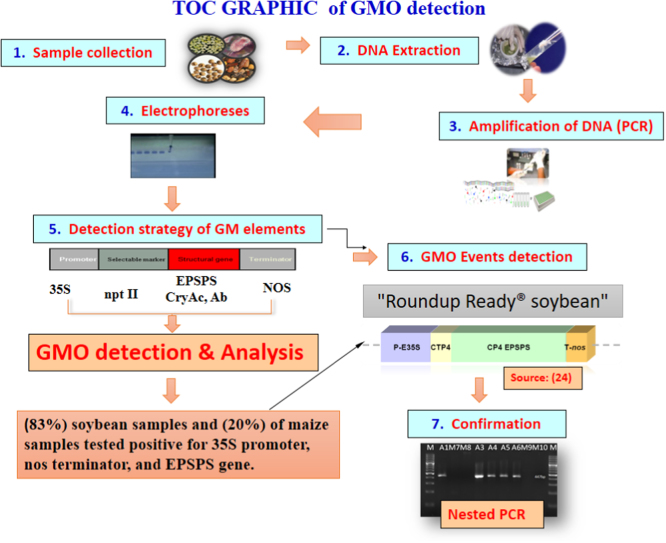
Summary of the methodologies and data presented [24].